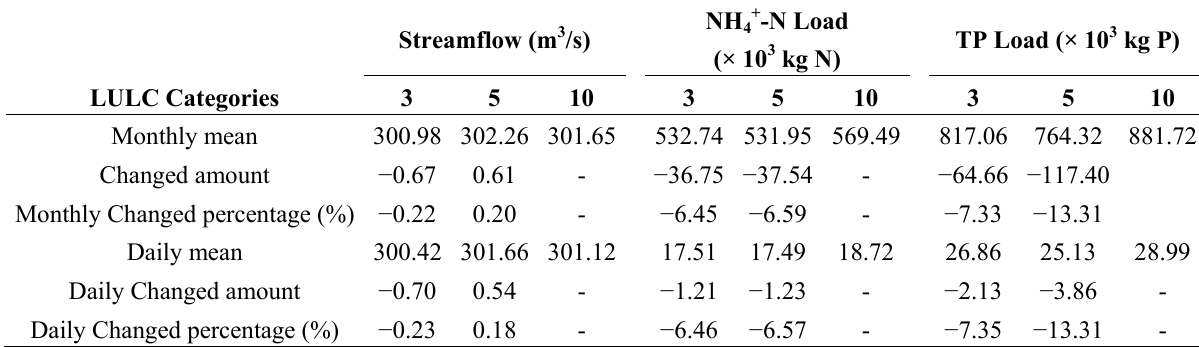
Table 6. Comparison of simulation output with regards to streamflow, NH 4+ -N and TP loads when using three LULC datasets with different levels of classification.